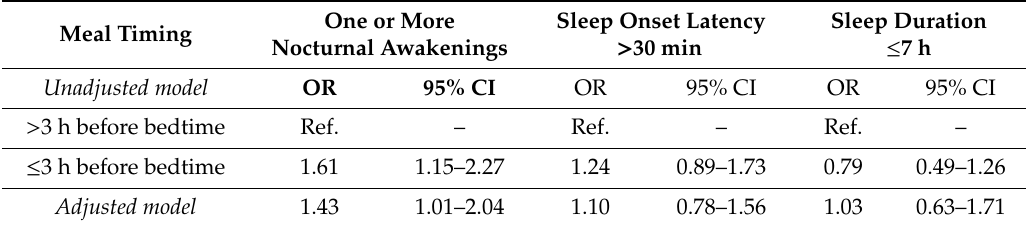
Table 2. Association between meal timing and sleep parameters with and without adjustment for covariates by logistic regression analysis ( N = 793). One or More Sleep Onset Latency Sleep Duration Meal Timing > 30 min ≤ 7 h Nocturnal Awakenings Unadjusted